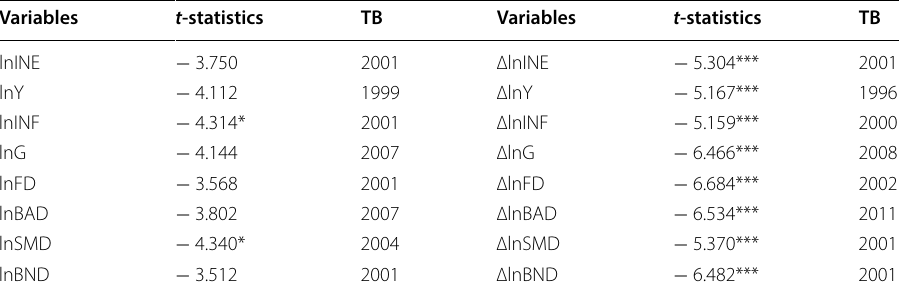
Table 2 Lee and Strazicich’s (2004) test with one endogenous structural break